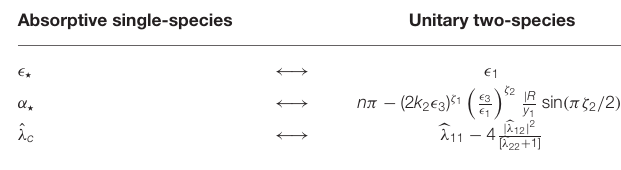
TABLE 1 | The dictionary that maps quantities in a two-bulk-species theory to quantities in a theory of a single bulk-species coupled to a point-particle with two accessible internal degrees of freedom.